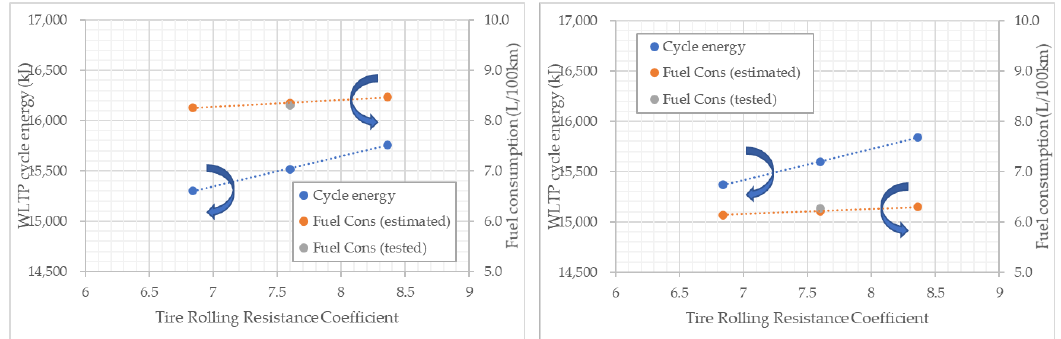
Figure 20. Effect of the tire rolling resistance on the cycle energy and fuel consumption in WLTP (left/right: gasoline/diesel).